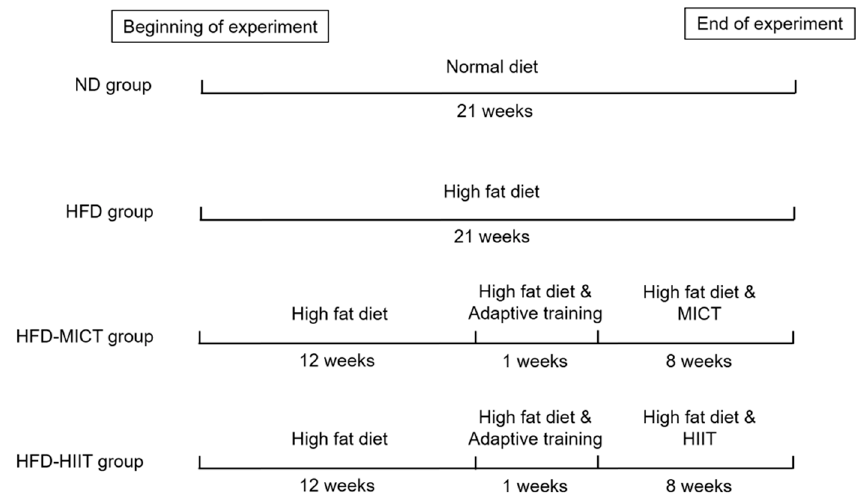
Figure 1. Schematic diagram of experimental design. ND: normal diet; HFD: high-fat diet; MICT: moderate-intensity continuous training; HIIT: high-intensity interval training.